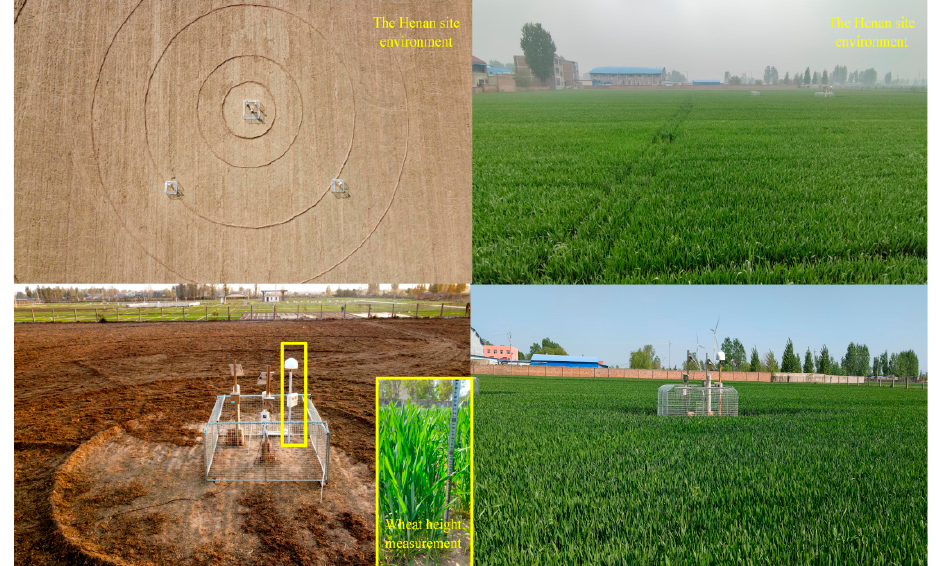
Figure 5. The site instrument, equipment and surrounding environment.